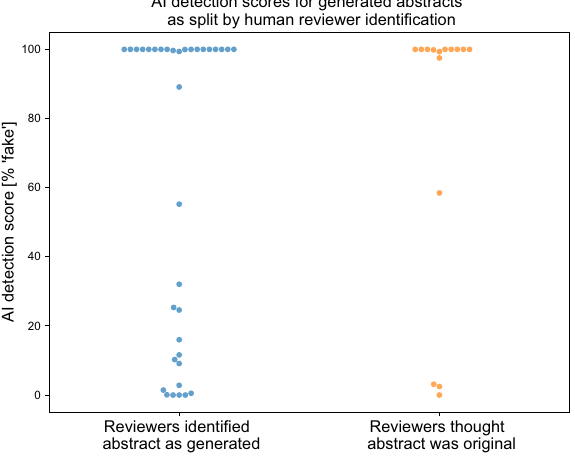
Fig. 4 Reviewers use criteria different than the AI output detector for fl agging abstracts as either generated or original. The AI detection scores for generated abstracts were not signi fi cantly different ( p = 0.45) between abstracts that human reviewers identi fi ed as generated, and those that they failed to identify as generated.